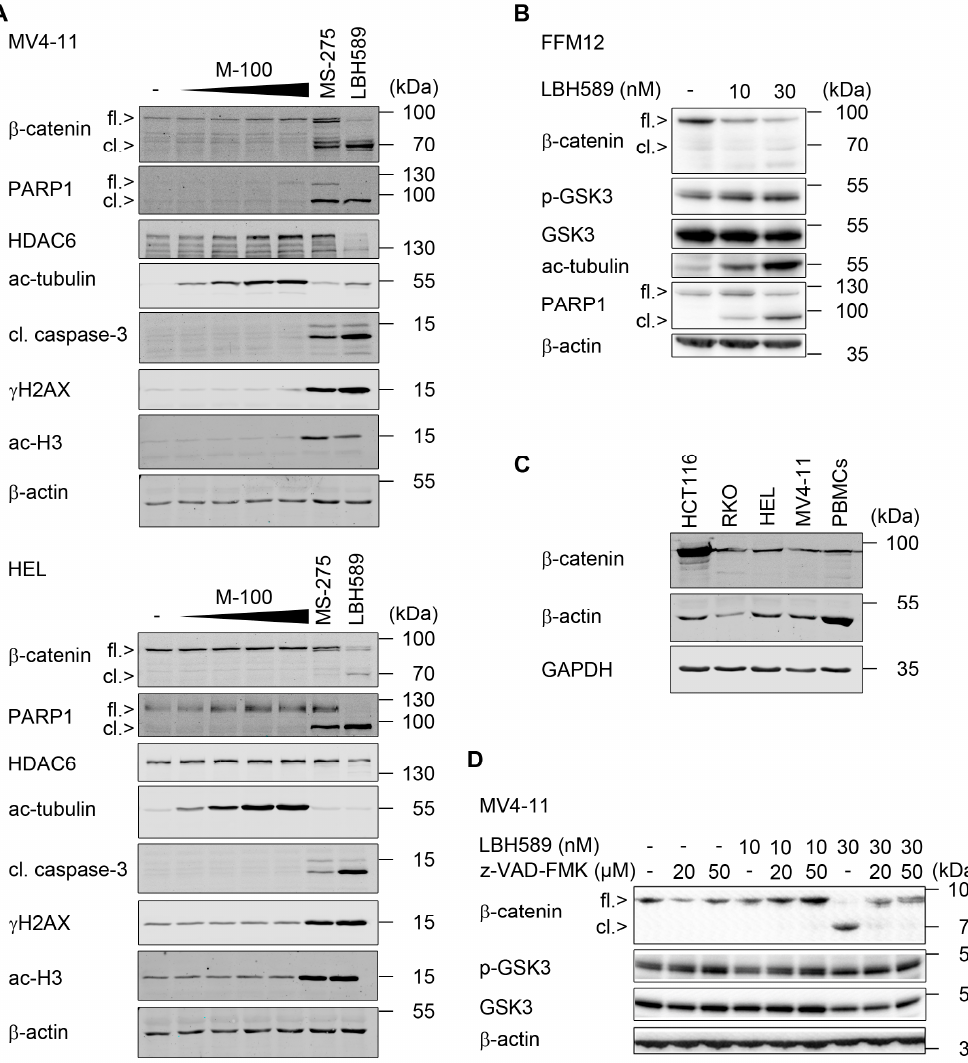
Figure 2. Caspases cleave β -catenin in leukemic cells. ( A ) MV4-11 and HEL cells were treated with increasing doses of marbostat-100 (M-100; 50 nM, 100 nM, 500 nM, and 1 µ M), 5 µ M of MS-275, or 30 nM LBH589 for 24 h. Whole cell extracts were analyzed by Western blot as indicated (cl., cleaved; ac, acetylated), with β -actin as a loading control ( n = 2). ( B ) Primary human FFM12 acute myeloid leukemia (AML) cells were incubated with 10 nM or 30 nM LBH589 for 24 h. Whole cell extracts were blotted for β -catenin, phosphorylated (p-) and total GSK3 β , and PARP1; β -actin as loading control. ( C ) Indicated human cell lines and peripheral blood mononuclear cells (PBMCs) were compared regarding their β -catenin status. Whole cell extracts were analyzed by Western blot, with GAPDH and β -actin as loading controls ( n = 2). ( D ) MV4-11 cells were pretreated with 20 µ M or 50 µ M of the pan-caspase inhibitor z-VAD-FMK for 1 h, followed by stimulation with 10 nM or 30 nM LBH589 for 24 h. Whole cell extracts were blotted for the indicated proteins and β -actin as a loading control ( n = 2).2.3. Indomethacin Can Accentuate Anti-Proliferative Effects of LBH589.